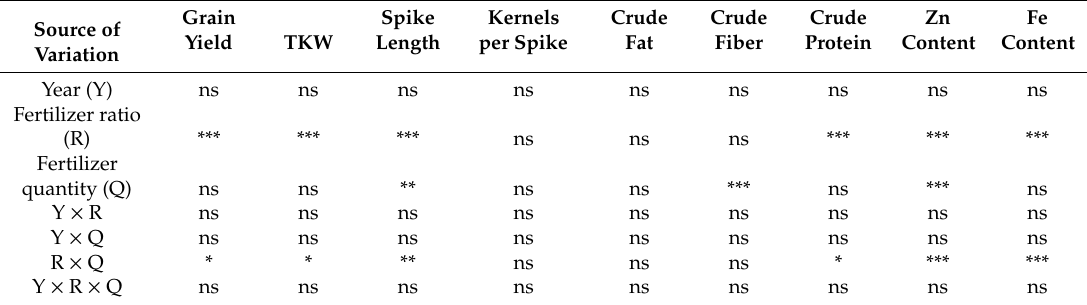
Table 2. Analysis of covariance (ANCOVA) of the e ff ects of fertilizer ratio and quantity and their interactions on grain yield, thousand kernel weight (TKW), spike length, kernels per spike, crude fat, crude fiber, crude protein, Zn content and Fe in 2 cropping